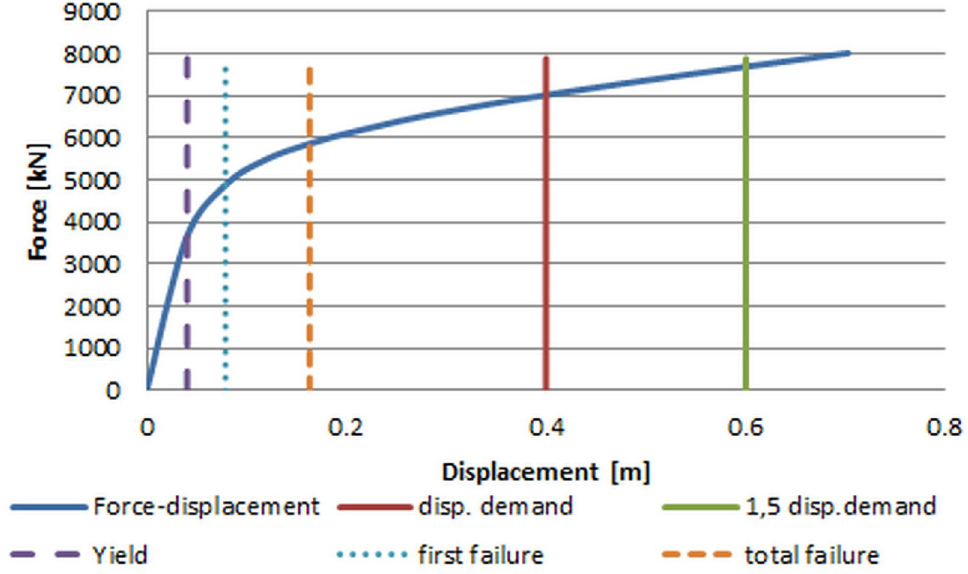
Figure 8. Force–displacement curve for the capacity design of the building, X-direction.